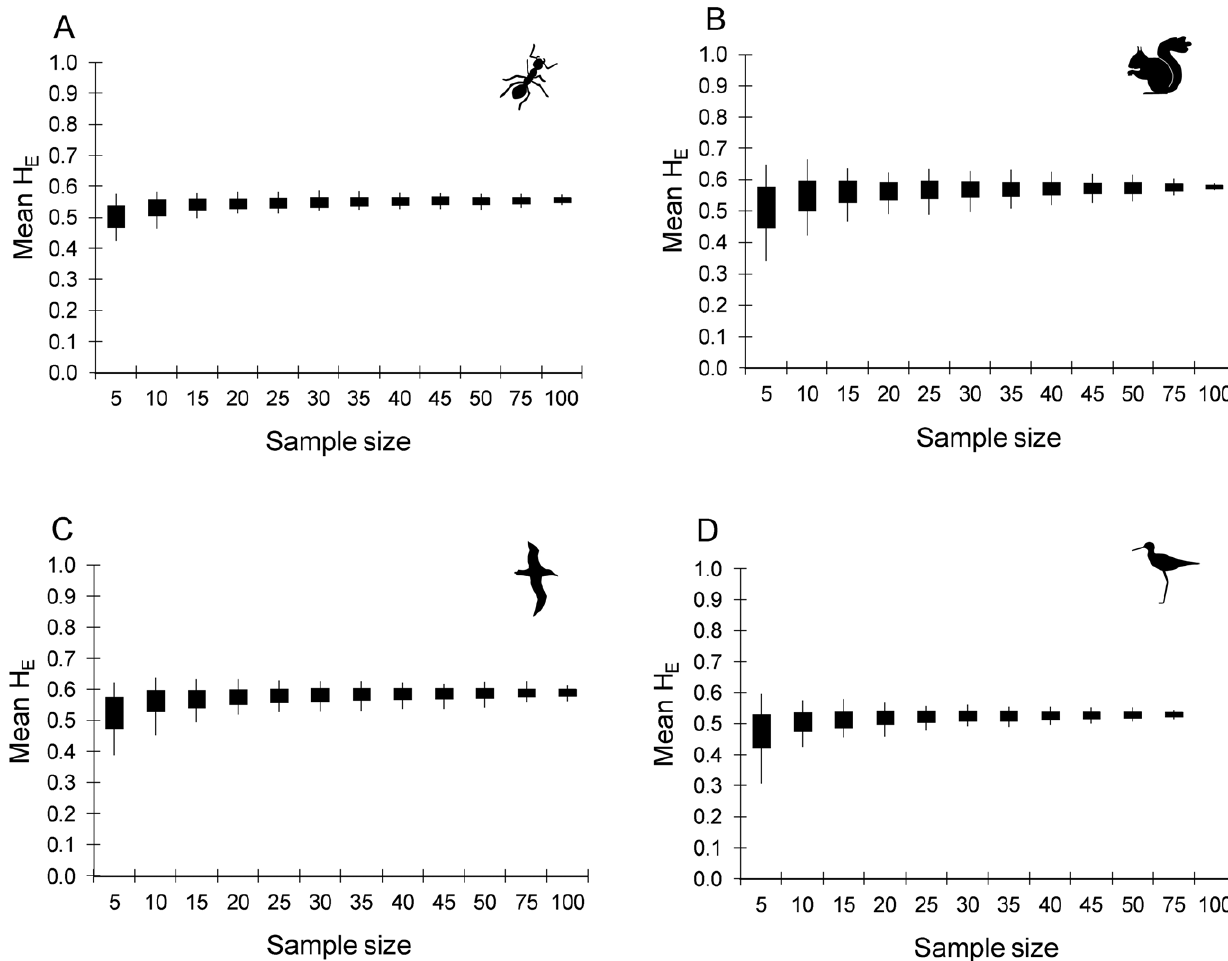
Figure 5. Impact of sample size on the accuracy and precision of mean heterozygosity across loci. The range (lines) and mean 6 one standard deviation (solid boxes) of mean expected heterozygosity (H E ) for the 100 random replicates at each sample size for A) the ant dataset (9 loci), B) the squirrel dataset (5 loci), C) the albatross dataset (7 loci) and D) the kakı¯ dataset (8 loci).